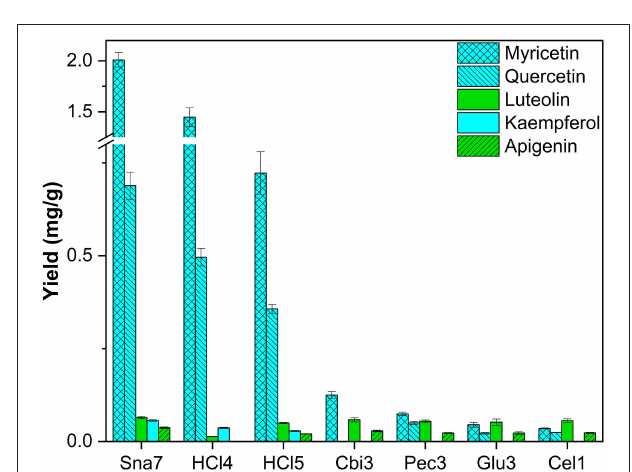
FIGURE 9 | Aglycone yields (mg/g) from leaf extracts of F. sylvatica . Enzymatic hydrolysis (25min): Sna7: 5mg snailase (pH 5.5, 37 ◦ C); Cbi3: 5U cellobiase (pH 4.5, 37 ◦ C); Pec3: 20U pectinase (pH 4.5, 40 ◦ C); Glu3: 20U β -glucosidase (pH 5.5, 37 ◦ C); Cel1: 20U cellulase (pH 5.5, 52 ◦ C). Acidic hydrolysis (60